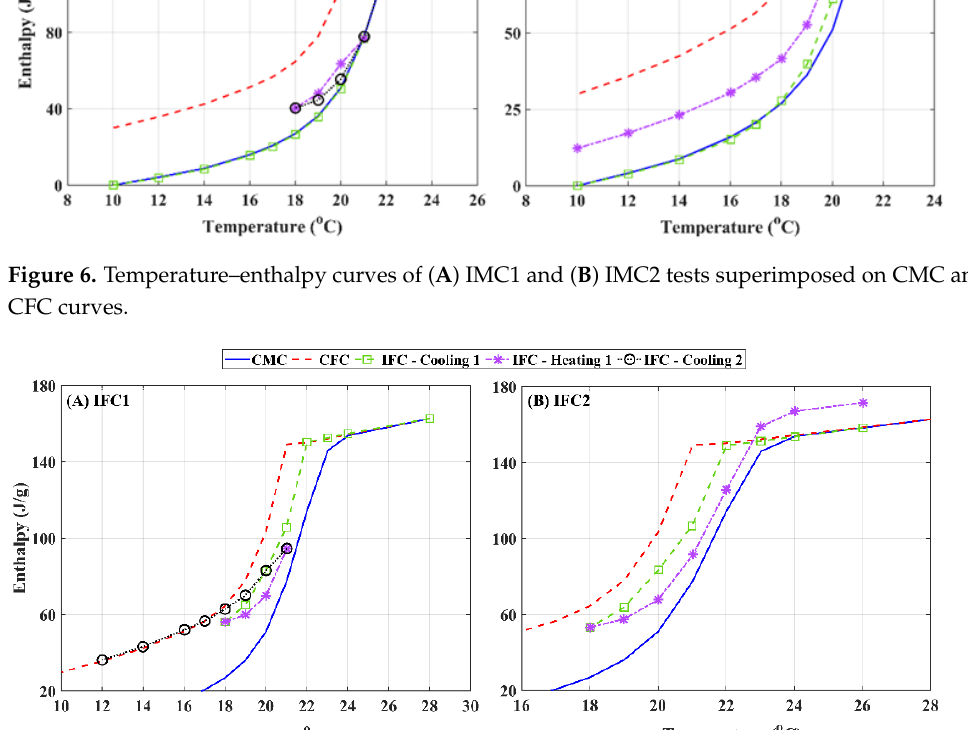
Figure 7. Temperature–enthalpy curves of ( A ) IFC1 and ( B ) IFC2 tests superimposed on CMC and CFC curves.